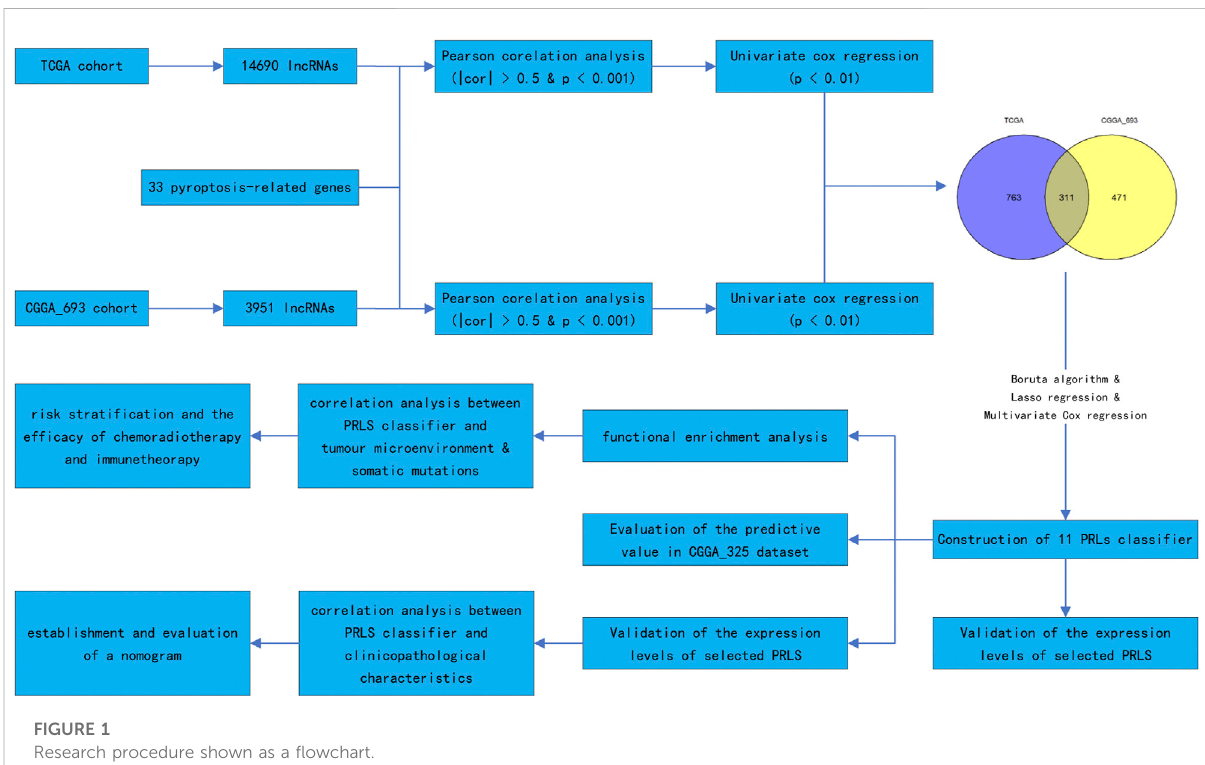
FIGURE 1 Research procedure shown as a fl owchart.